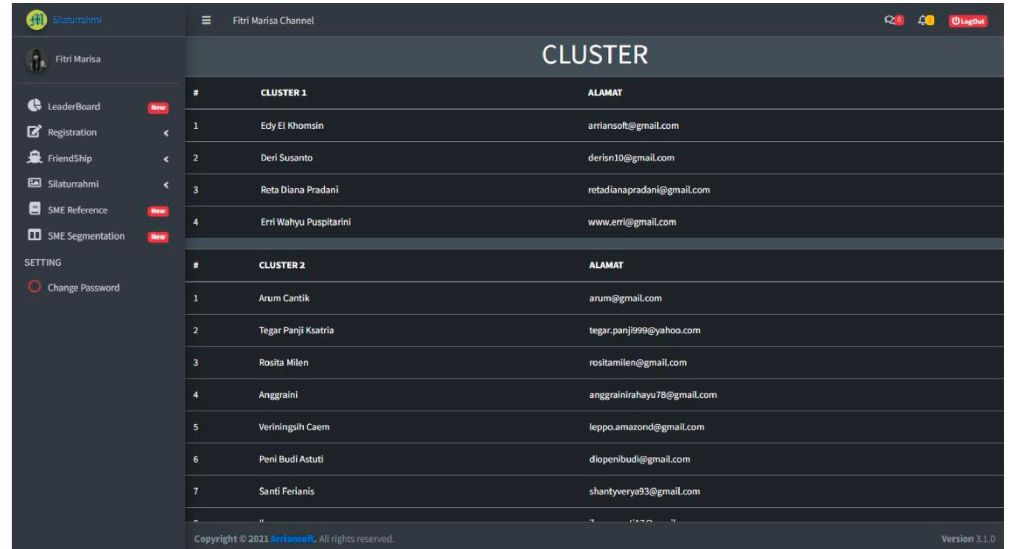
Figure 4: SME segmentation using